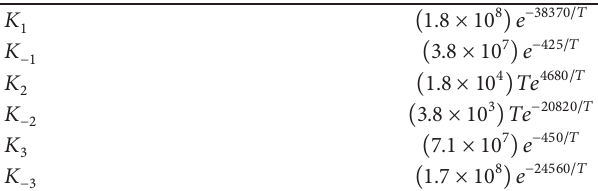
Table 1: Thermal NO 𝑥 reaction rate constants [m 3